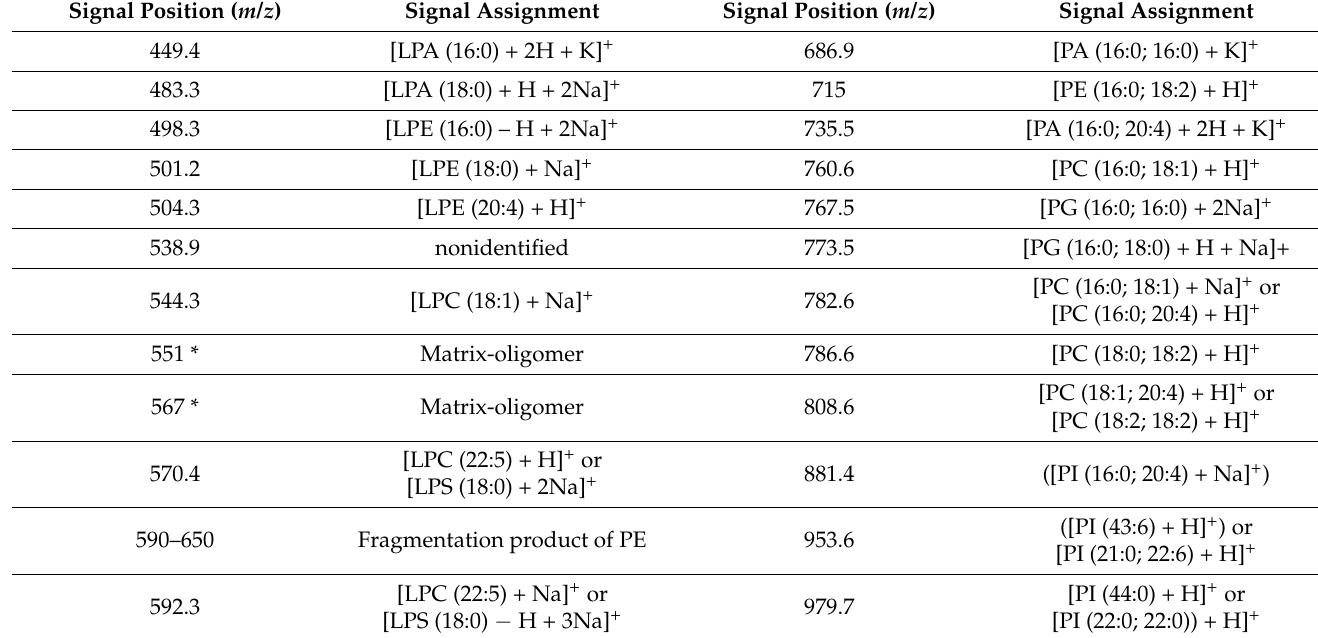
Table 2. Signal position and the assignment of cation species ( + ) related to lipids obtained from mass spectra. Peaks with an asterisk (*) correspond to the higher molecular weight oligomers of the DHB